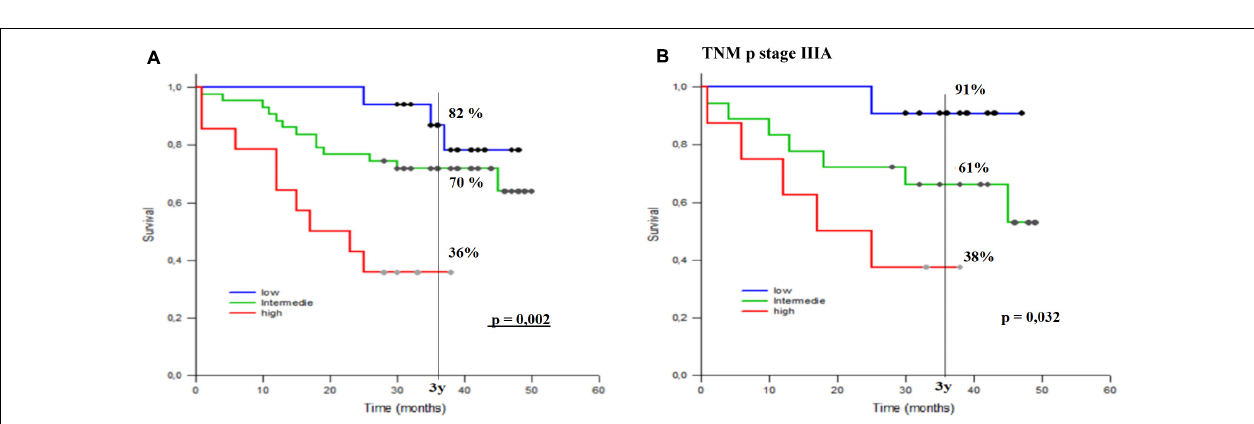
FIGURE 7 | Three-year survival rate (3yOS) data and curves according to low, intermediate, and high combined peritumoral (PT) immunoscore integrated with derived neutrophil/lymphocyte ratio (dNLR) [absolute neutrophil count/(white blood cell concentration - absolute neutrophil count)] in all patients (A) and in those with pStage IIIA (B) . The combined PT immunoscore is given by the combination of different PT inflammatory components (PT CD8+, S CD4+, S CD68+).